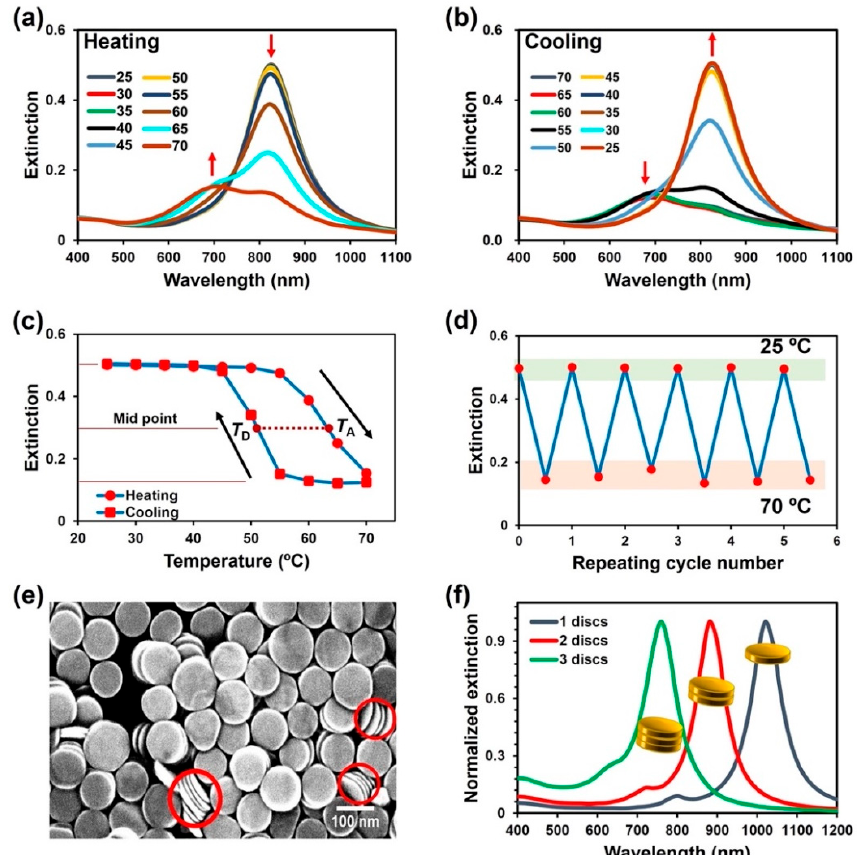
Figure 2. Thermo-responsive assembly of 105-AuND-(97:3): ( a ) the extinction spectra of 105-AuND- (97:3) upon heating from 25 to 70 ◦ C and ( b ) upon cooling from 70 to 25 ◦ C; ( c ) the extinction values at 827 nm against temperature changes; ( d ) the reversible changes in extinction values between 25 and 70 ◦ C; ( e ) SEM mode image of AuNDs dried at 60 ◦ C on the TEM grid obtained by STEM observation; ( f ) FDTD simulation of AuNDs of 100 nm in diameter and 6 nm in thickness. The dispersed single AuND (blue), face-to-face assembly of double (red) and triple AuNDs (green) are with a 3 nm gap distance. The red arrows in ( a , b ) indicate the plasmon peak changes. T A and T D in ( c ) represent the assembly and disassembly temperature, respectively, while the dotted red line indicates the degree of hysteresis. The red circles in ( e ) indicate the pancake-like, face-to-face assembly of 105-AuND-(97:3). Table 1. The assembly ( T A ) and disassembly ( T D ) temperatures of AuNDs and AuNSs modified with a mixture of C1 and COOH ligands.